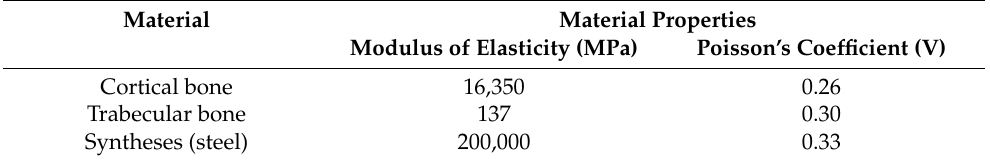
Table 1. Material